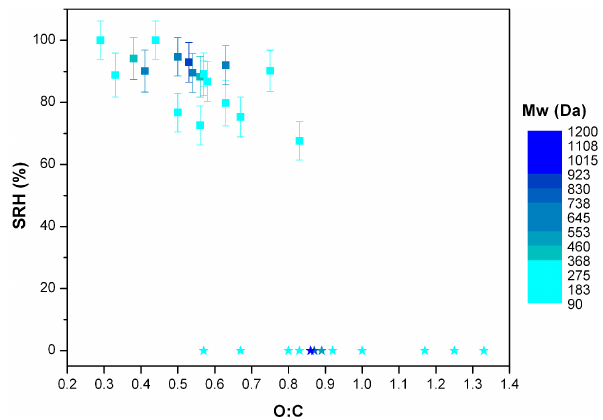
Figure 3. SRH as a function of O:C of the organic species at 290 ± 1K. The SRH results are from the current study and You et al. (2013) (see Table 3). The colors represent the molecular weight of the different organic species. Squares represent the SRH of particles in which liquid–liquid phase separation was observed. Bars for the squares are 95% confidence intervals considering σ of multiple SRH measurements and the uncertainty from the calibra- tion. Stars indicate liquid–liquid phase separation was not observed. OIR = 2.0 ± 0.1in all the